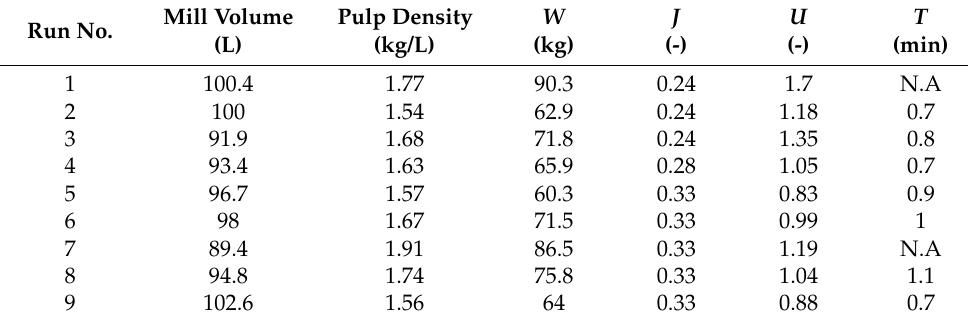
Table 2. Derived mill